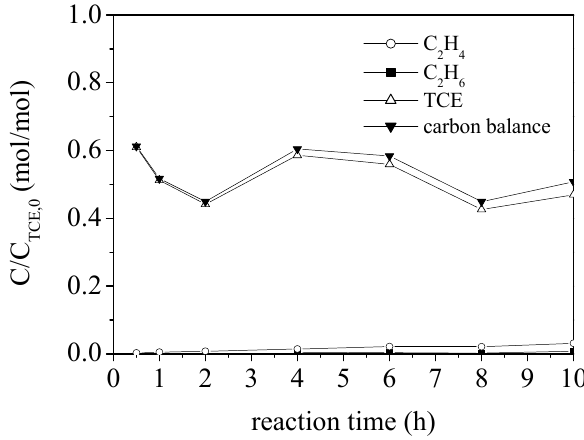
Figure A3. Degradation of trichloroethylene and production of ethylene and ethane on Pd/Fe nanoparticles supported on mesoporous silica with a weight percentage of Pd to Fe at 0.050%.